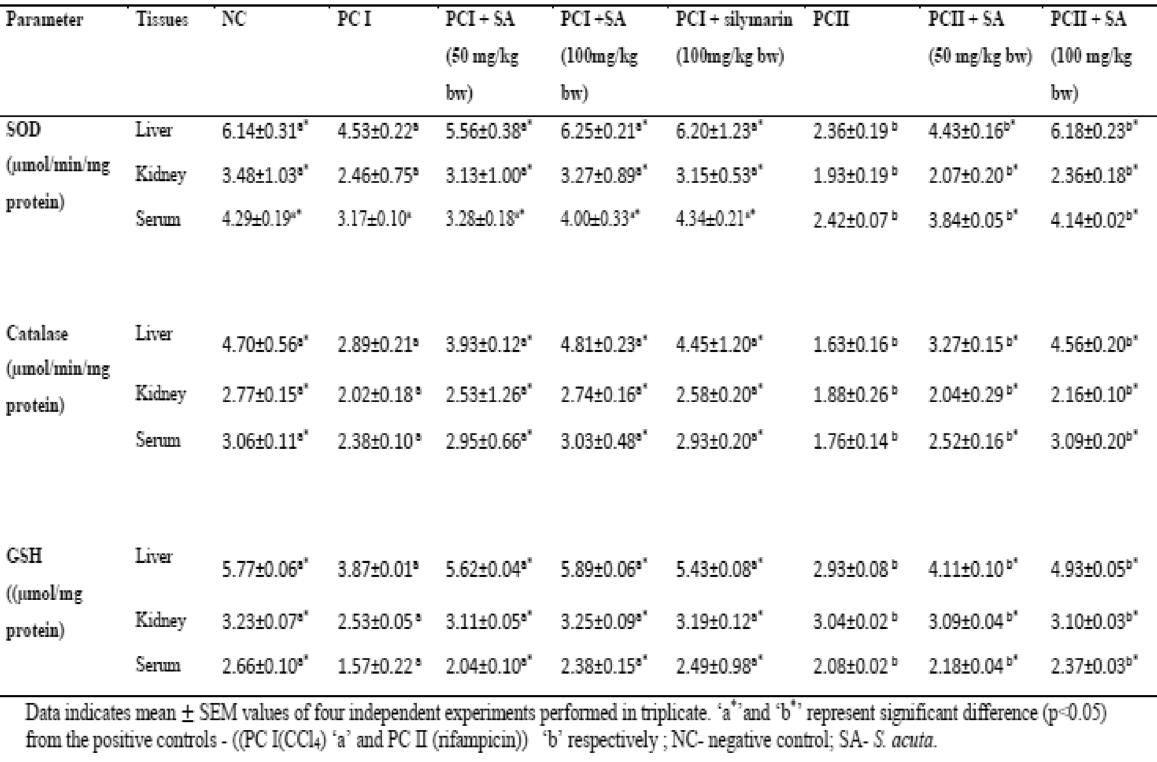
Data indicates mean ± SEM values of four independent experiments performed in triplicate. ‘ a* ’ and ‘ b* ’ represent significant difference ( p <0.05) from the positive controls – ((PC I(CCI4) ‘ a ’ and PC II (rifampicin)) ‘ b ’ respectively; NC- negative control; SA- S.